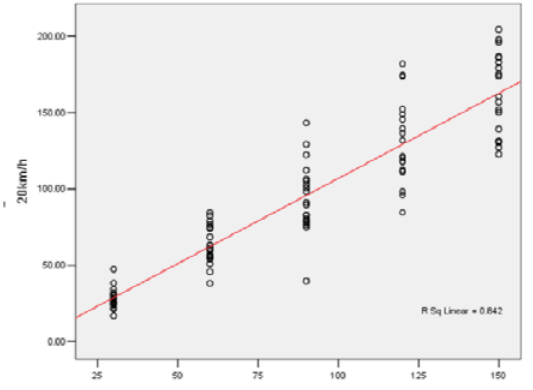
Fig.7. Text height and legibility distance relationship at speed